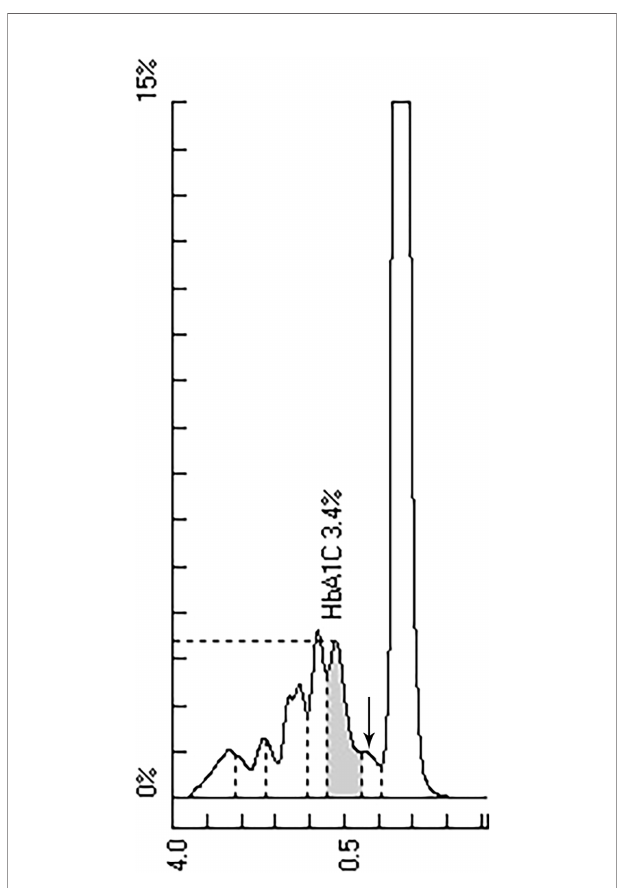
FIGURE 1 | HPLC chromatogram of HbA1c. Abnormal peak marked by